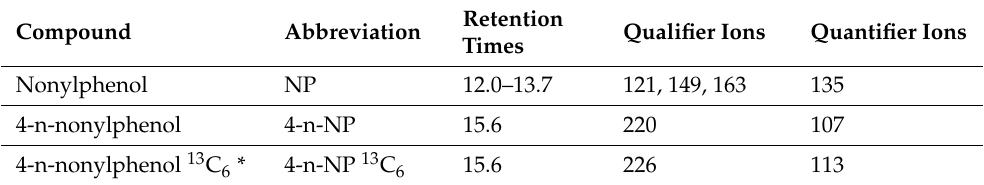
Table 1. Mass spectral parameter of the analyzed